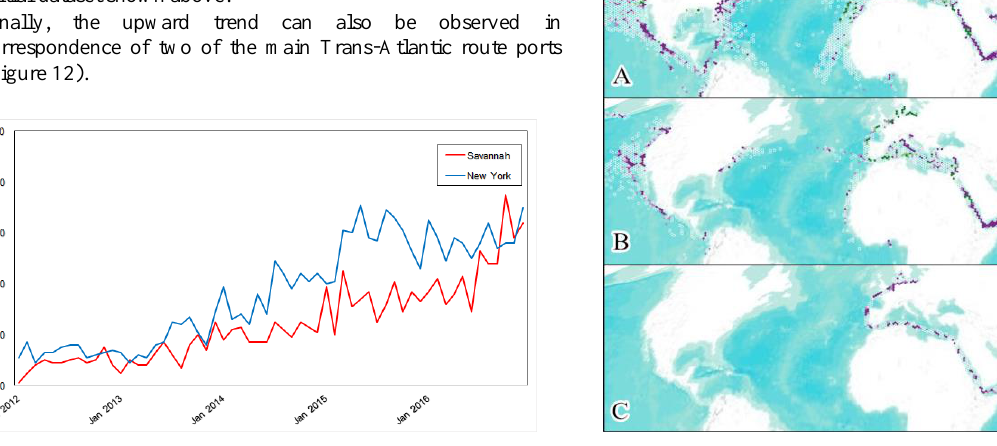
Figure 12 Variation of counted AIS’ positions per bin in Savannah and New York port locations (2012-2016).